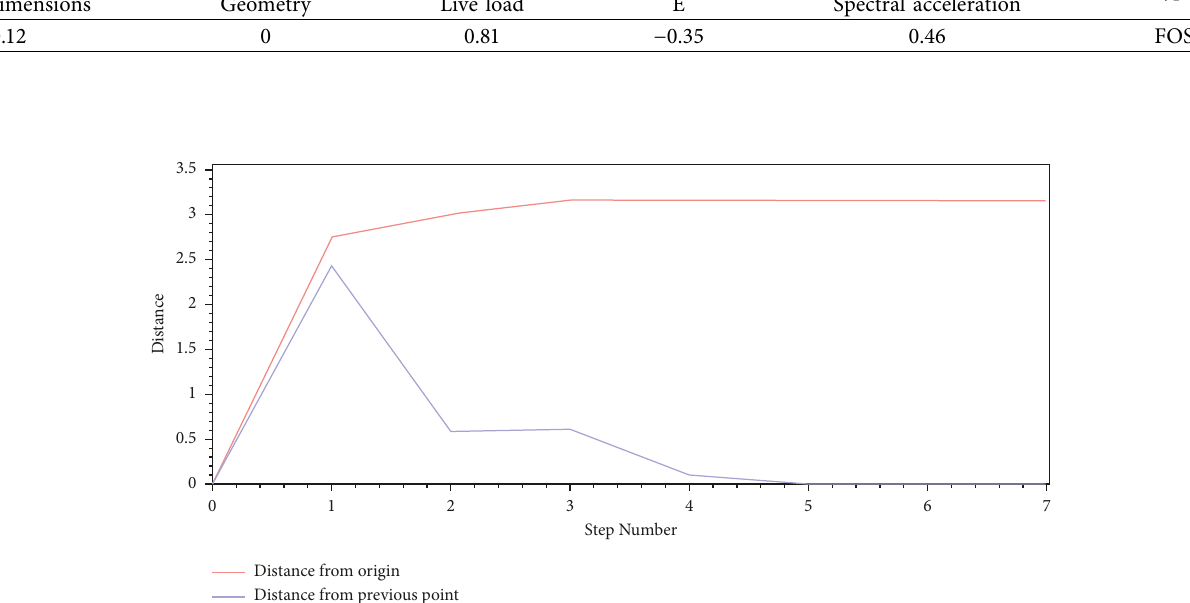
Figure 15: Convergence diagram of FORM analysis for type V frame in RT program.